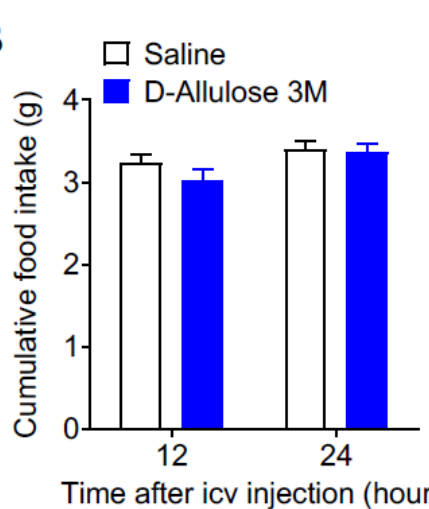
Figure 4. Icv injection of D -allulose inhibits feeding in the early dark phase in mice. Saline (0.9% NaCl, 3 μ L; control) or D -allulose (3 M, 3 μ L) was icv-injected at 18:00 in mice fasted 11 h. ( A ) D -allulose had no effect on cumulative food intake until 19:00 in light phase, and significantly decreased cumulative food intake at 20:00 and 22:00 in the early dark phase at 2 and 4 h after icv injection. Data are presented as mean ± SEM. * p < 0.05 and *** p < 0.001 by two-way ANOVA followed by Bonferroni’s multiple comparisons test, n = 7–8. ( B ) D -allulose altered cumulative food intake neither at the next day 6.00 (12 h after icv injection) in the late dark phase nor at 18.00 (24 h after icv injection) in light phase. Data are presented as mean ± SEM. No difference was observed between groups by two-way ANOVA followed by Bonferroni’s multiple comparisons test, n = 7–8.